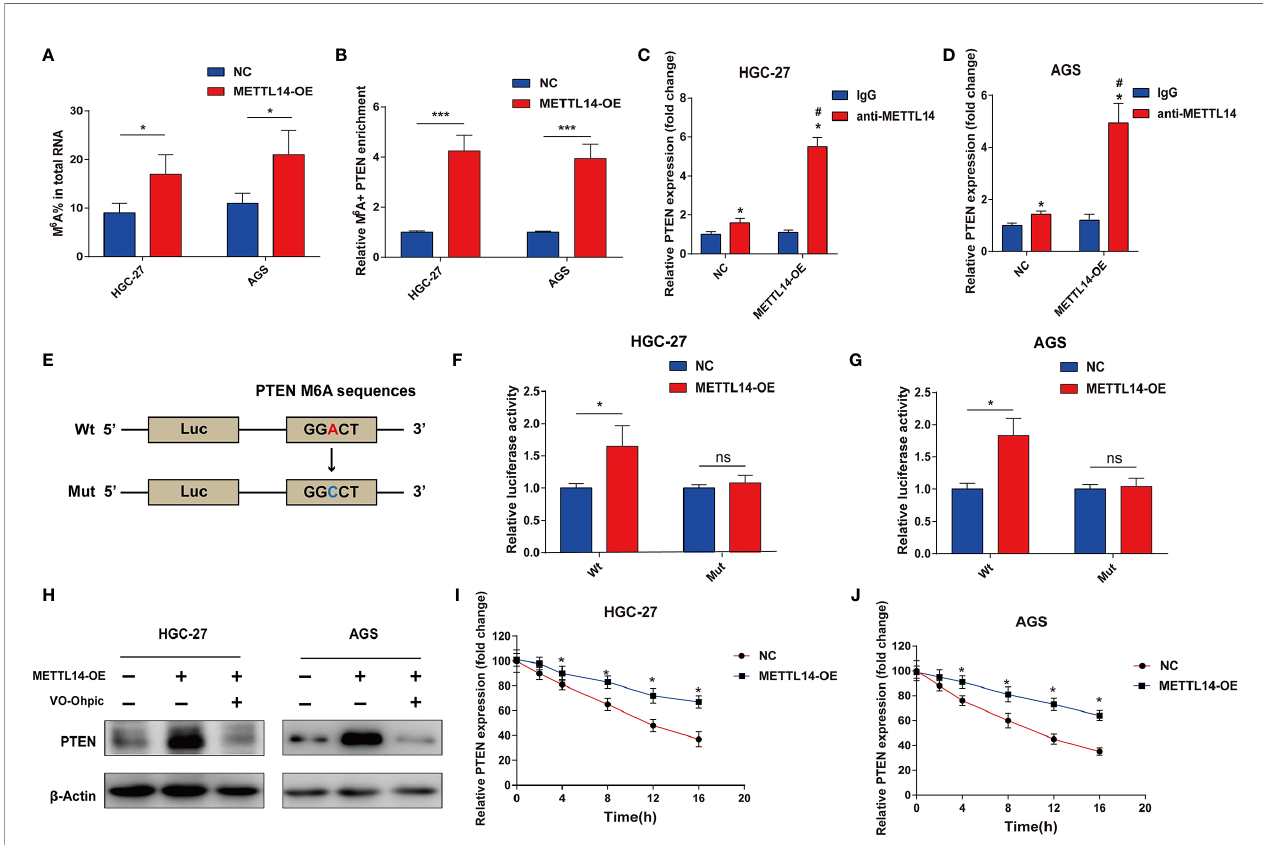
FIGURE 4 | METTL14 regulates PTEN mRNA expression via m6A modi fi cation in STAD. (A) M6A modi fi cation level of total RNA was detected after METTL14 overexpression in HGC-27 and AGS cells. (B) Enrichment of m6A in PTEN was detected after METTL14 overexpression in HGC-27 and AGS cells (***P < 0.001). (C , D) RIP-qPCR assay were used to detect the enrichment of METTL14 binding PTEN in HGC-27 and AGS cells (*, vs IgG, P < 0.05; #, vs anti-METTL14 in NC group, P < 0.05). (E) Luciferase reporters of wild type and mutation PTEN were constructed. (F , G) Relative luciferase activity were detected after transfecting wt- PTEN 3 ′ -UTR-Luc or mut-PTEN 3 ’ -UTR-Luc reporter vectors in METTL14 overexpression or negative control STAD cells *P < 0.05; ns, no signi fi cant difference. (H) METTL14 overexpression mediating PTEN upregulation was antagonized by the PTEN inhibitor, VO-Ohpic, in HGC-27 and AGS cells. (I , J) The overexpression of METTL14 extended the half-life of PTEN mRNA in HGC-27 and AGS cells. *P <